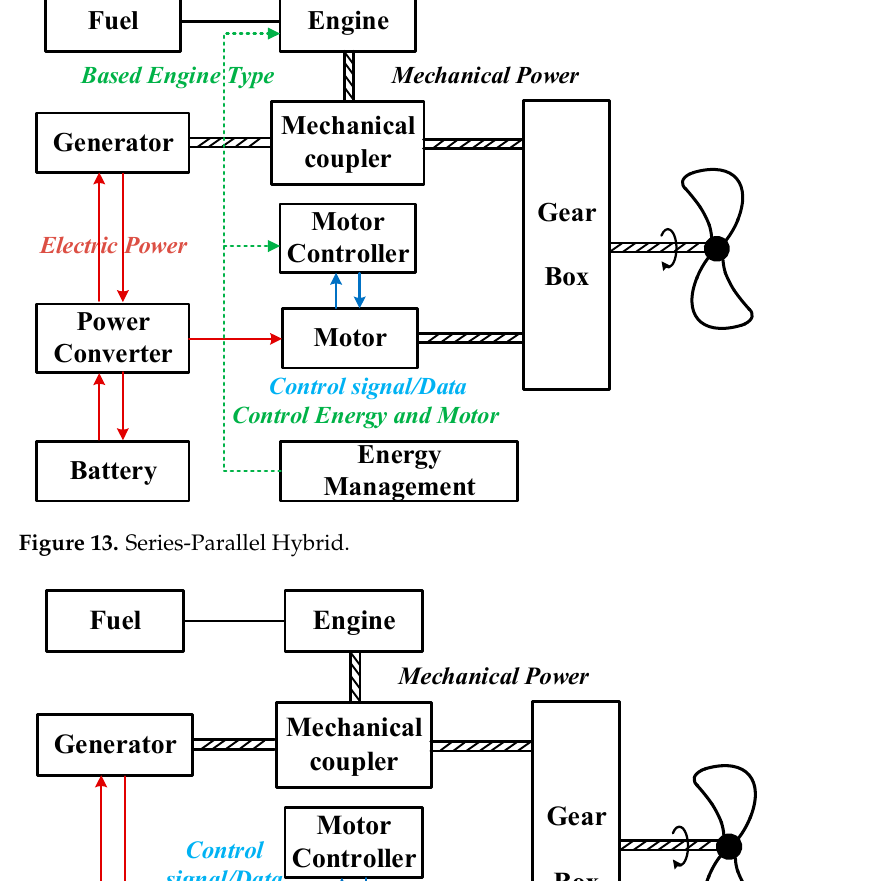
Figure 14. Complex hybrid.